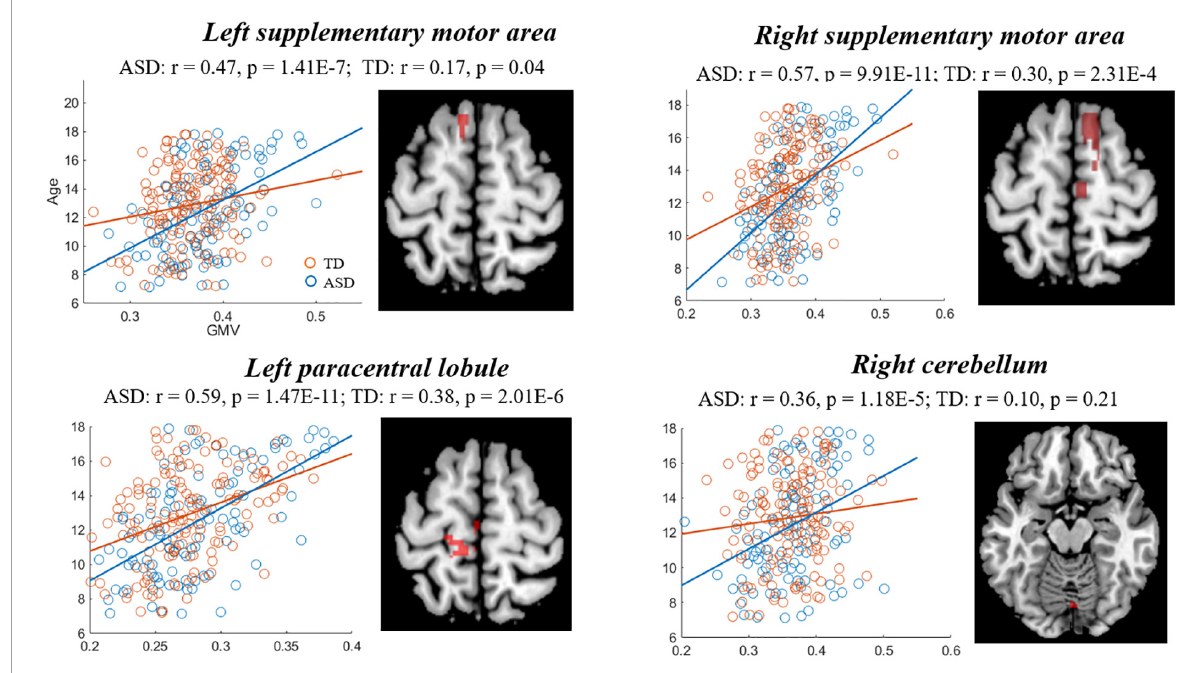
FIGURE4 Correlations between gray matter volume (GMV) and age showing significant differences between autism spectrum disorder (ASD) and typically developing (TD). Blue and red represent the ASD and TD,